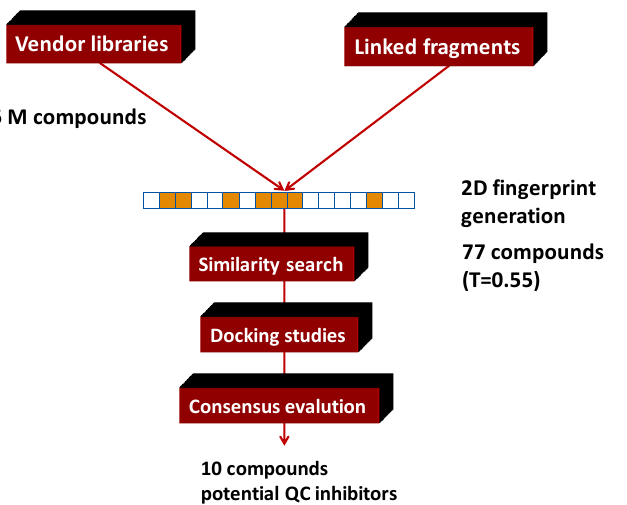
Figure 16. A 2D similarity selection of a focused library around the glutaminyl cyclase linked frag- ment.